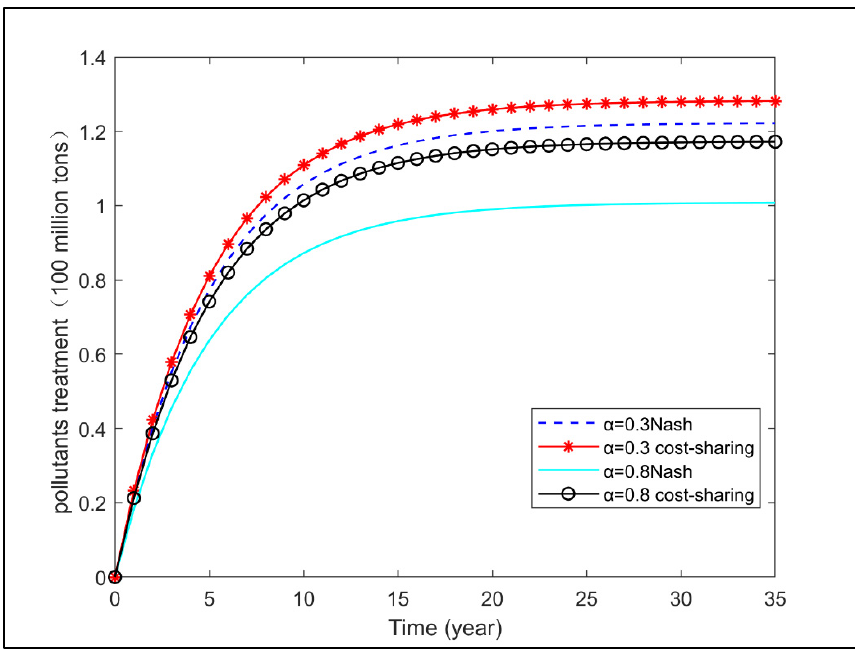
Figure 4. The effects on pollutants treated.